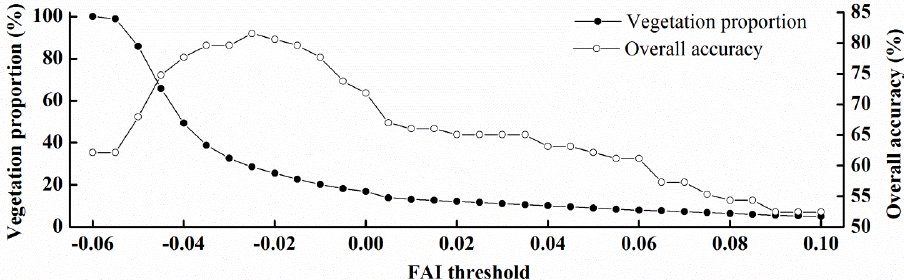
Figure 4. Variation in vegetation signal coverage proportion and overall accuracy with variation in the FAI threshold on 8 October 2013.